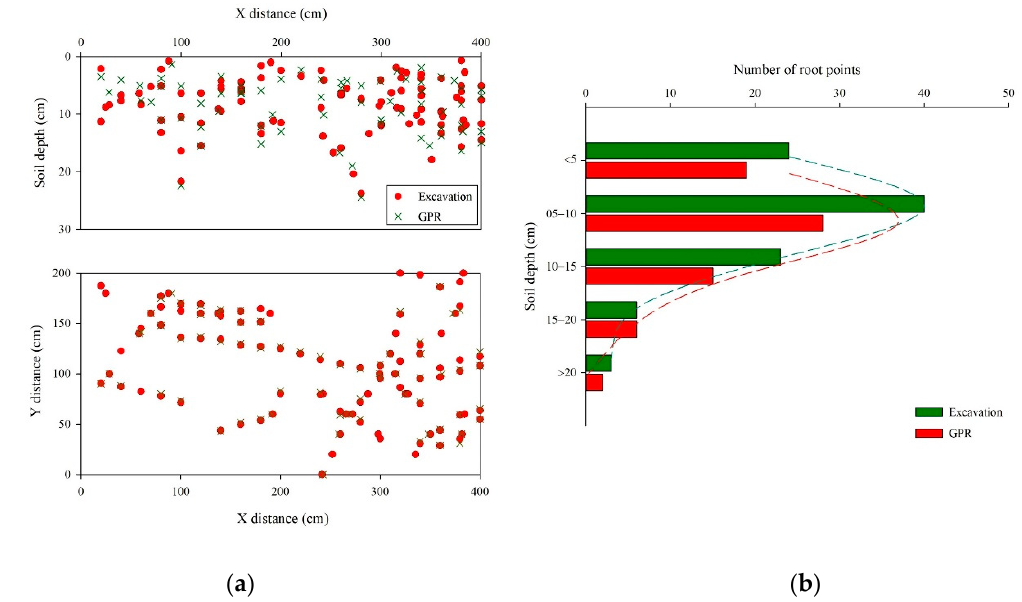
Figure 8. ( a ) Front (top panel) and ground plan (bottom panel) views of the distribution of root points obtained by excavation and ground-penetrating radar (GPR) methods. Green crosses represent root points identified by direct excavation, while red circles represent root points identified by GPR analysis; ( b ) Vertical distribution of rhizomes in the soil media, compared between data obtained by excavation (green) and GPR (red).